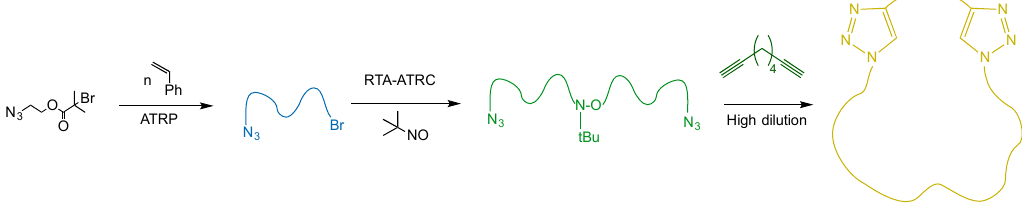
Scheme 2. Preparation of cyclic PS using consecutive “click” reactions. Characteristics of the precursor and products are shown in Figure 1.